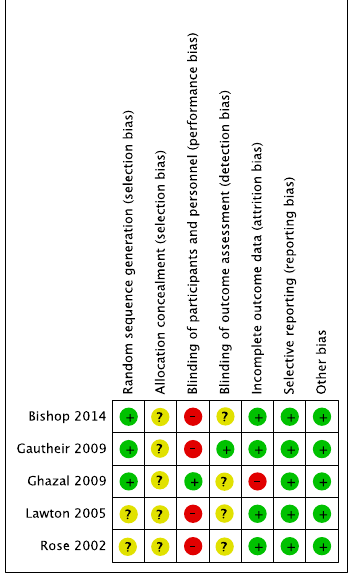
Figure 4. Assessment of risk of bias of the included studies (Bi-block OA m versus Bi-block OA m ) for systematic review.